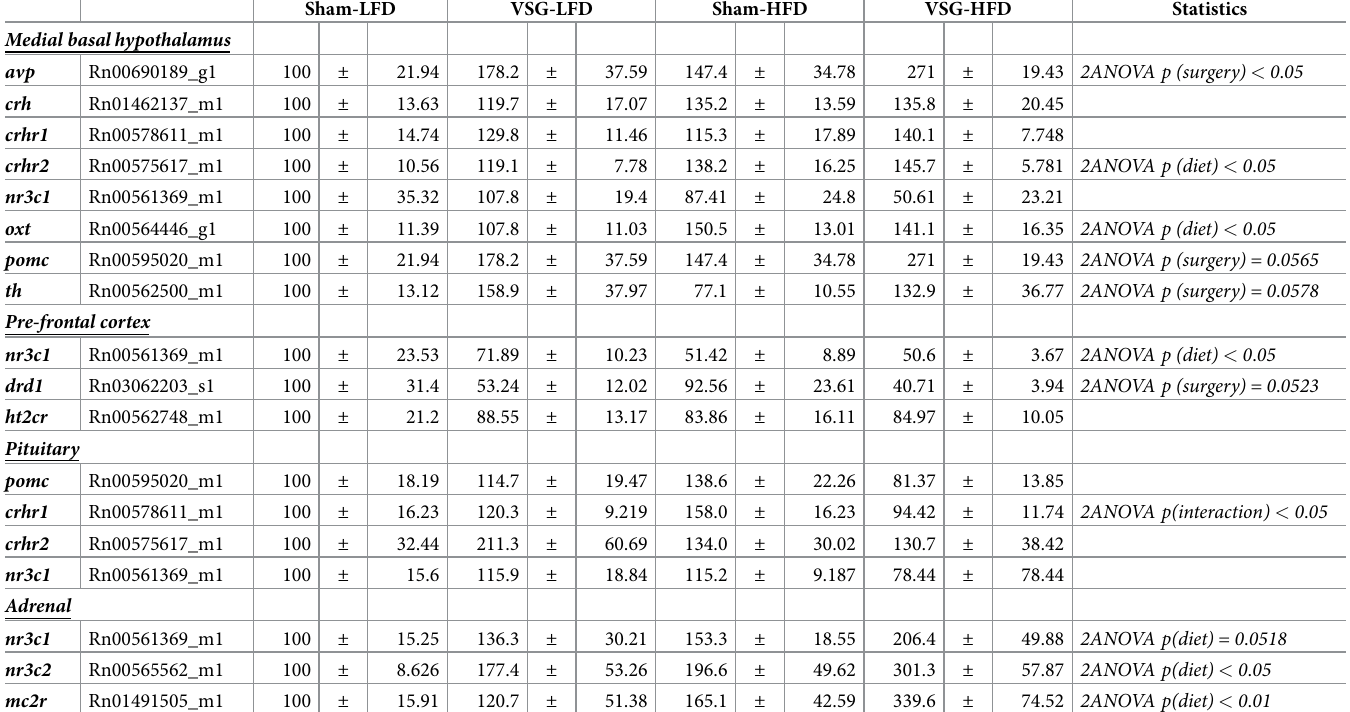
Table 2. Gene expression analysis of the medial basal hypothalamus, prefrontal cortex, pituitary and adrenal gland. Data are presented as mean ±SEM. N = 5-7/ group. Sham-LFD VSG-LFD